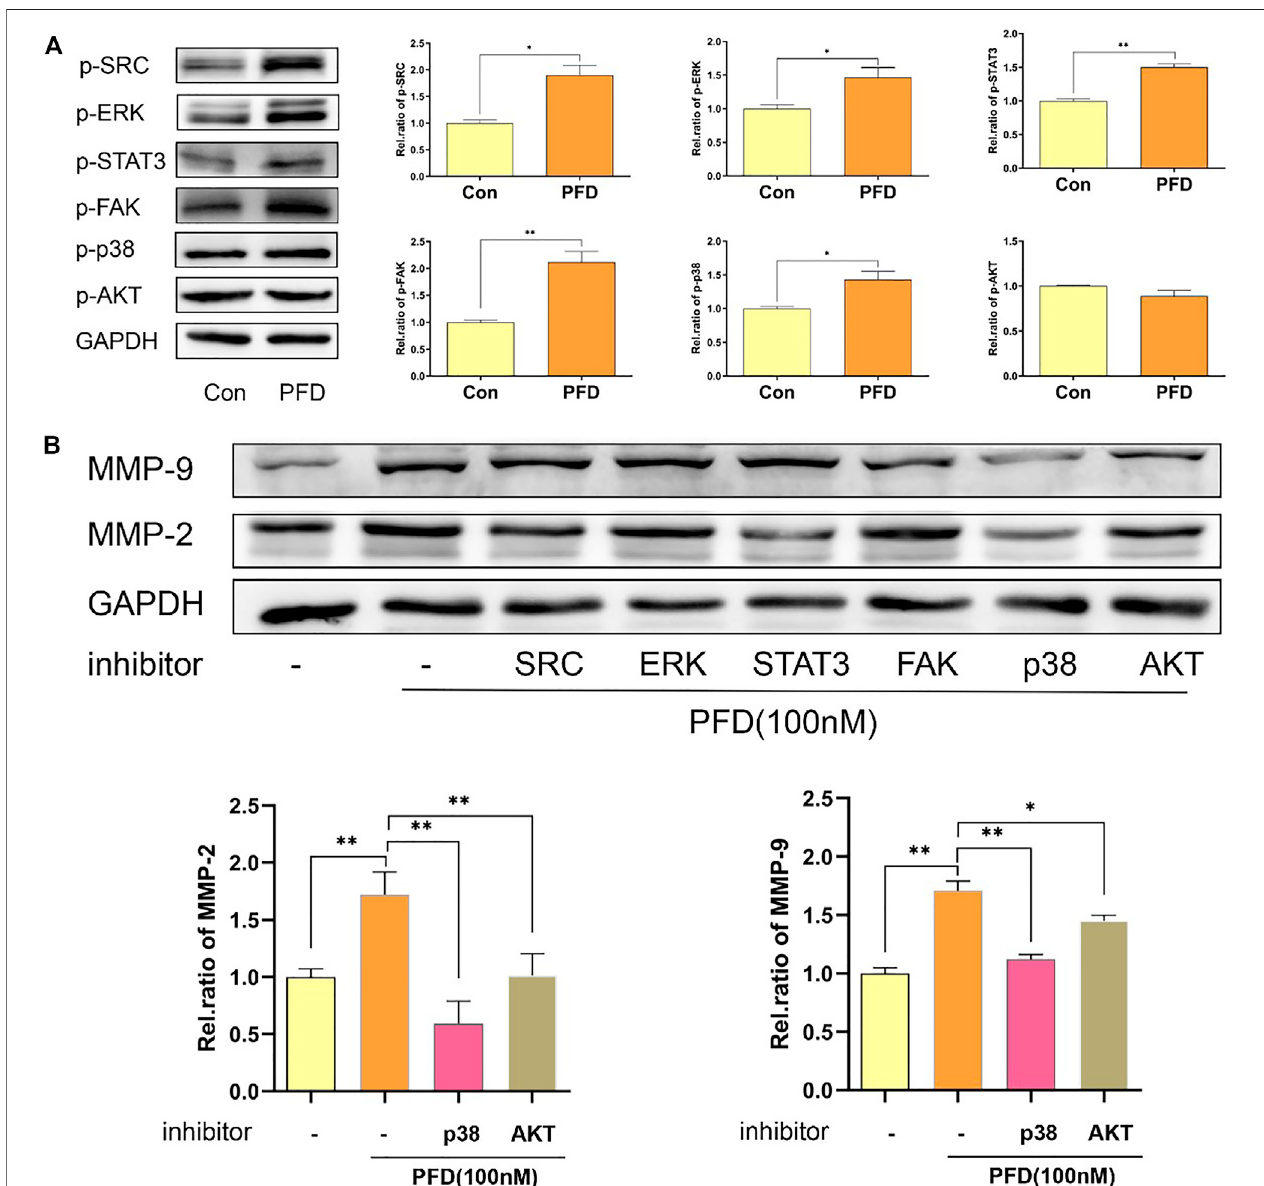
FIGURE 5 | PFD promotes the expression of MMP-2 and MMP-9 predominantly via p38 pathway and is independent of the TGF- β target in EA.hy926 cells. EA.hy926cellswerepre-treatedwithdifferentpharmacologicalinhibitorsfor30 minpriortoPFD(100 nM,24 h)stimulation,whichwasfollowedbyassessmentofMMP- 2and MMP-9 expression incell lysates bywestern blotanalysis. (A) PFD increased phosphorylation ofSTAT3, SRC,p38, FAKand ERK. PFD did nothave any effect on AKT phosphorylation. (B) Inhibitors of p38 and AKT signi fi cantly inhibited the PFD-stimulated increase in MMP-2 and MMP-9 expression. The cells were